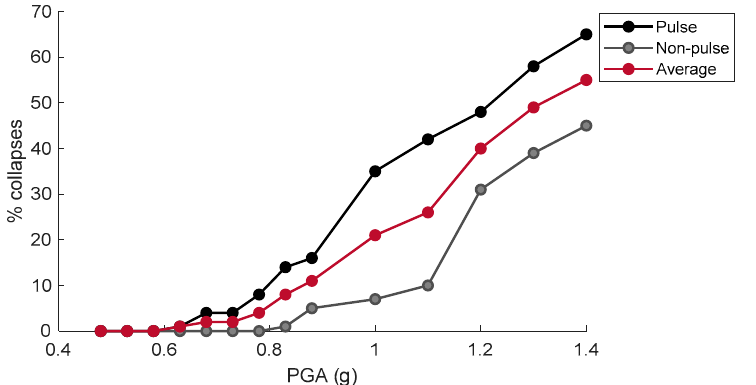
Figure 20. Church. Variation of number of collapses predicted using rocking dynamics with PGA,